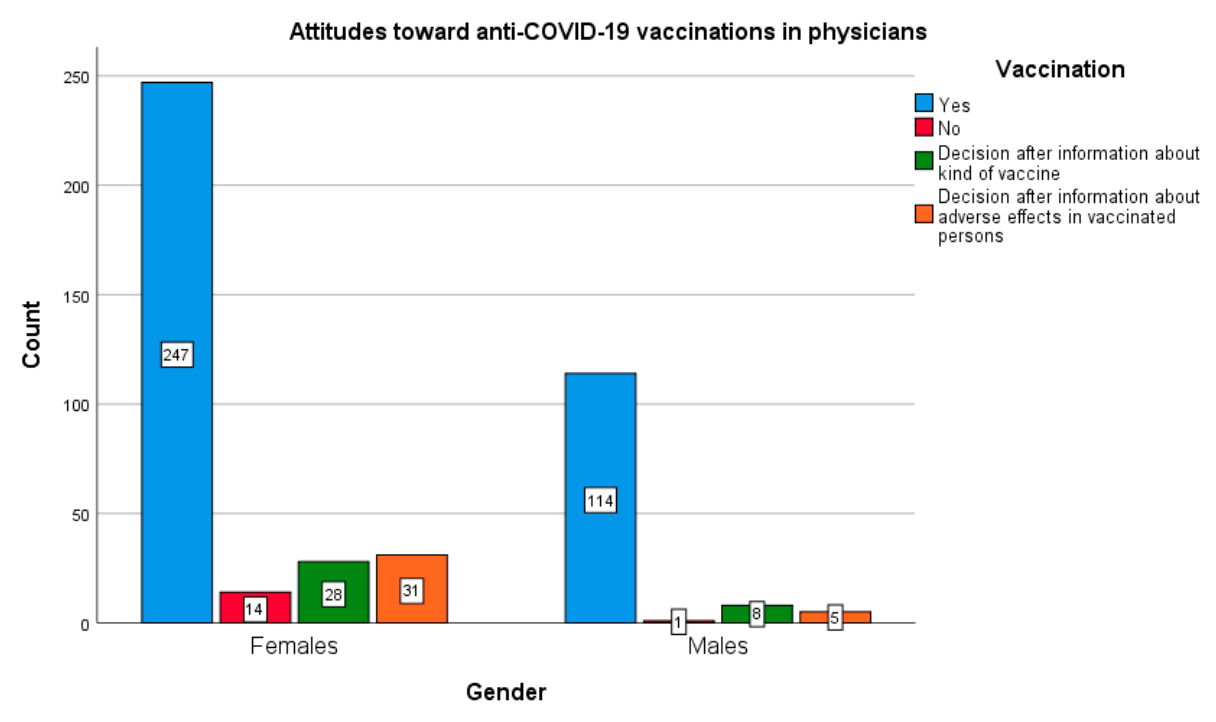
Figure 5. Gender and declared attitude towards the COVID-19 vaccination in the group of non-medical professions.